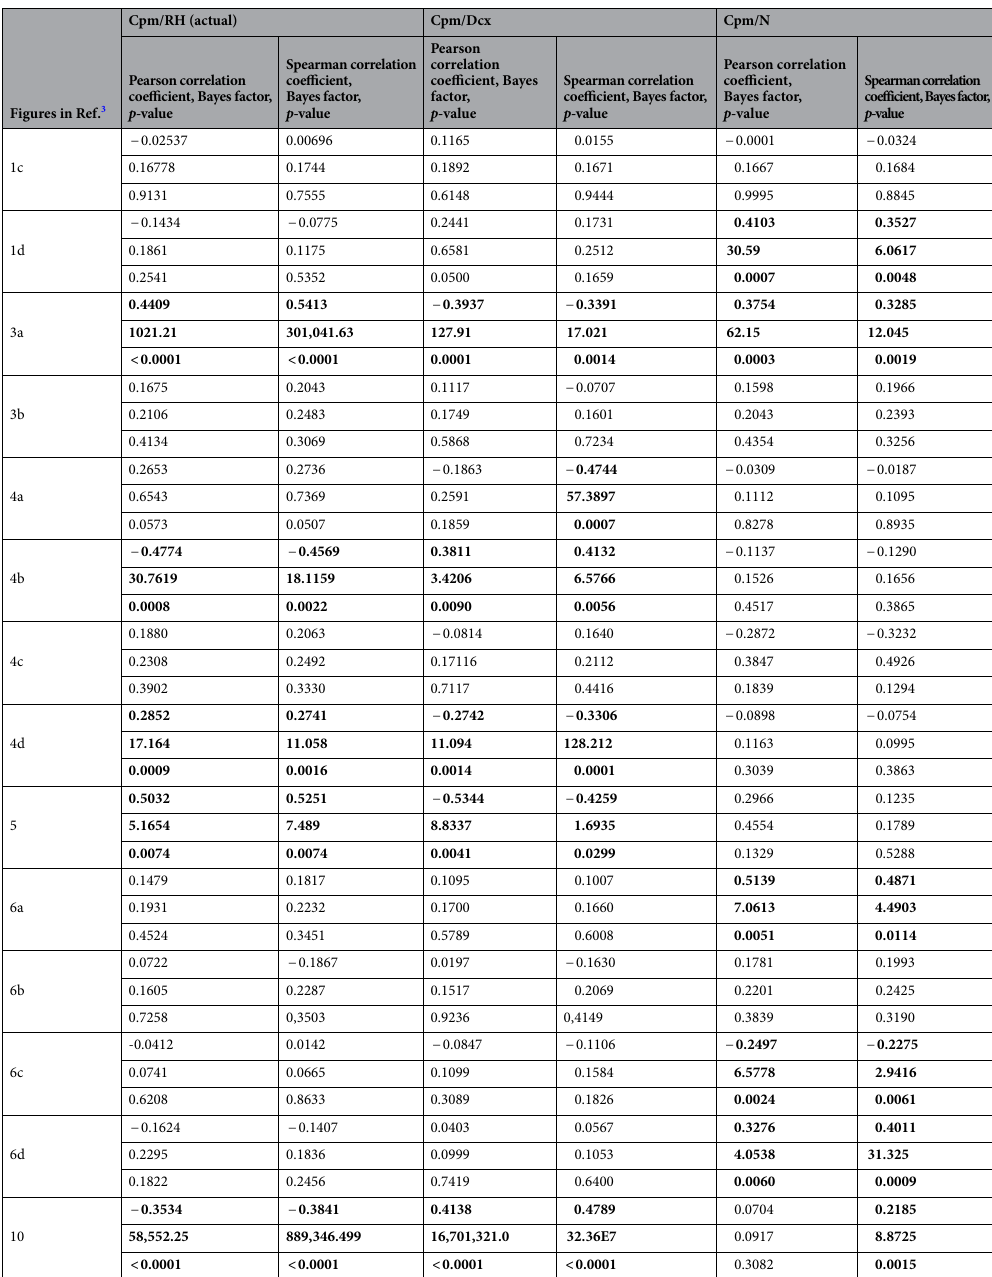
Table 1. Correlation analyses. The first column refers to the figure number in Ref. 3 . The next two columns are the statistical analysis results between the decay rates and the actual relative humidity, and the remaining four columns include the correlation analysis results with respect to geomagnetic activity (GMA) and cosmic-ray activity (CRA). Values marked in bold refer to significant correlations or anticorrelations; p -value cut-off is